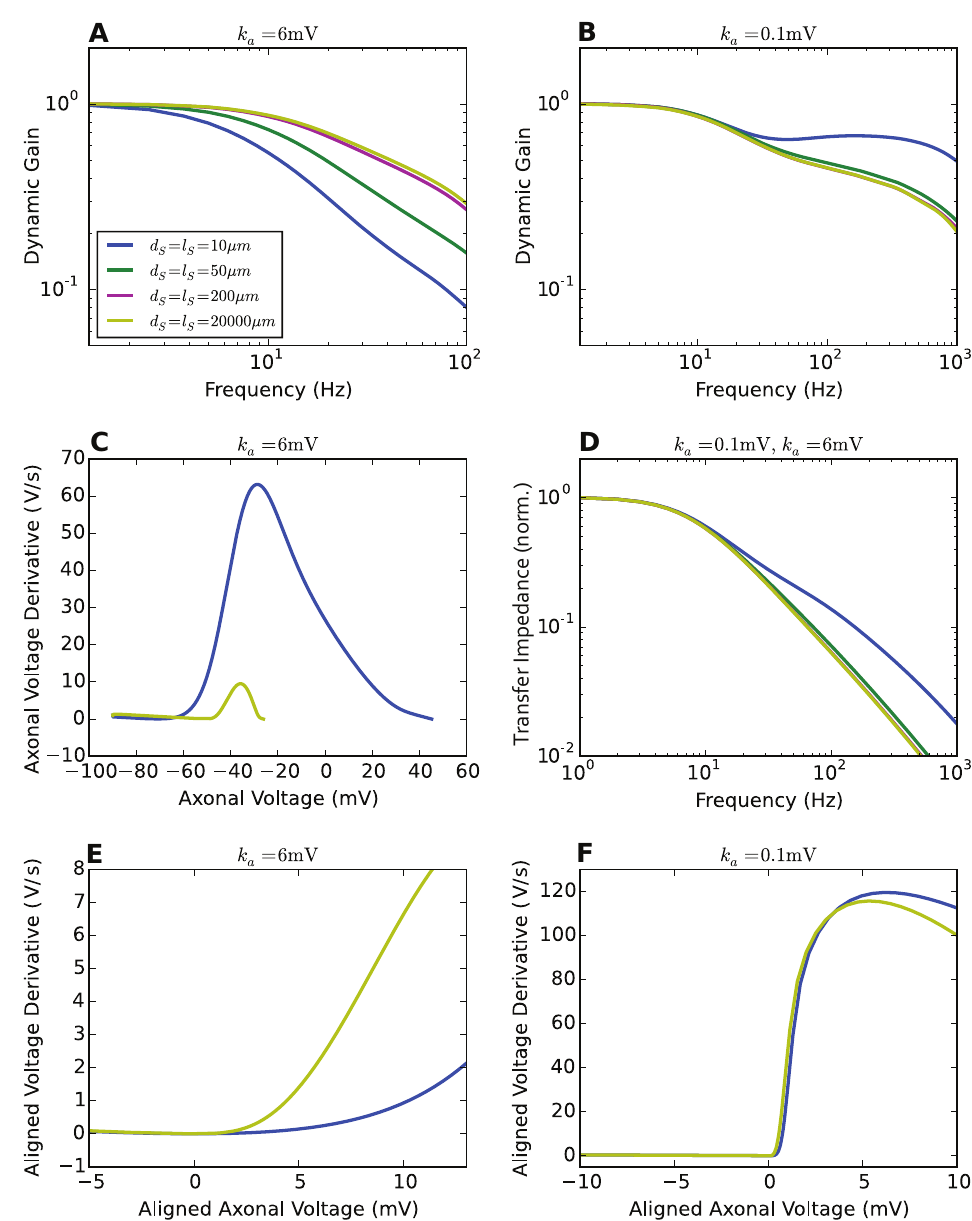
Fig 11. Transfer impedance and AP initiation dynamics for different soma sizes. A and B Dynamic gain functions of Brette’s model for a variety of soma sizes. k panel in A . C AP initiation dynamics seen at the axon with k a = 6mV. D Transfer impedance for different soma sizes. The passive neuron models are identical for both k aligned at (0mV,